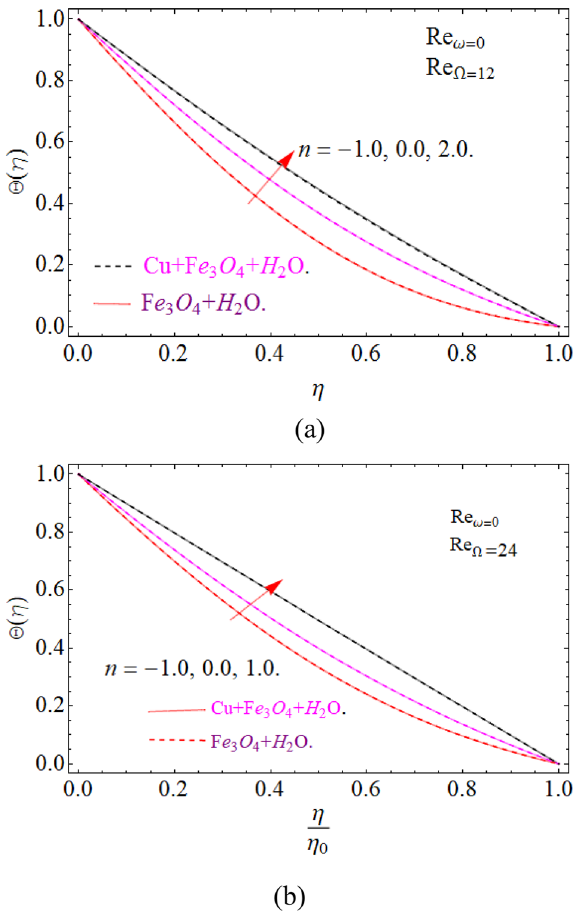
Figure 16. Impression of Θ( η ) amongst a stationary disk and rotating cone at three different radial exponents. ( a ) Re Ω = 12 and ( b ) Re Ω =